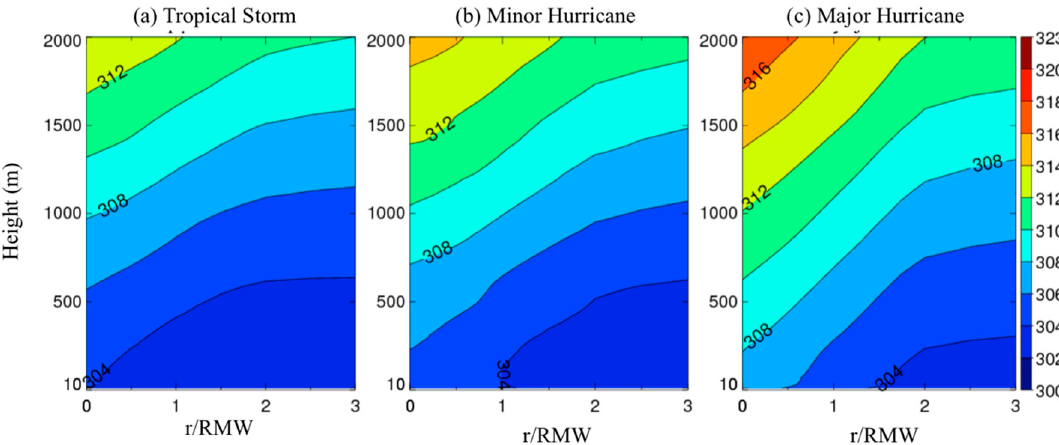
Figure 7. Composite analysis of the virtual potential temperature (in K) as a function of altitude and normalized radius to the storm center for ( a ) tropical Storms, ( b ) minor hurricanes, and ( c ) major hurricanes. The contour interval is 2 K in all panels.